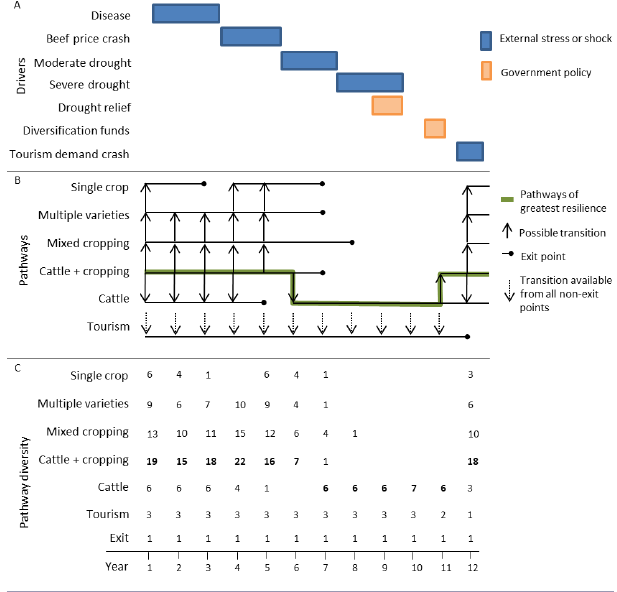
Fig. 3. Pathway diversity analysis of agricultural decision- making. (A) Drivers that influence the available options. (B) Available pathways. (C) Calculation of pathway diversity for each action at every point in time. The actions of maximum pathway diversity (numbers) in each year are